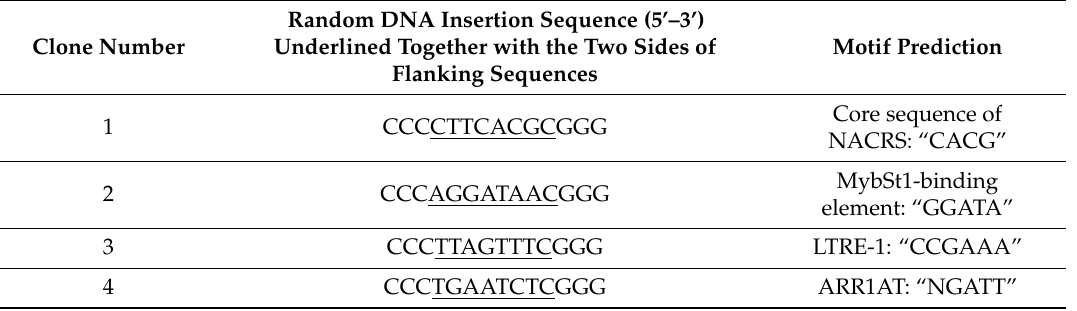
Table 1. Analysis of the insertion sequence that binds to